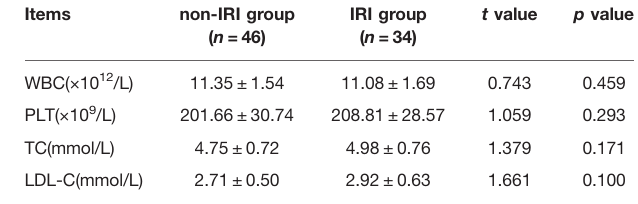
TABLE 1 | Basic information of patients ( n ,%). TABLE 3 | Examination parameters of patients ( n , x + s).